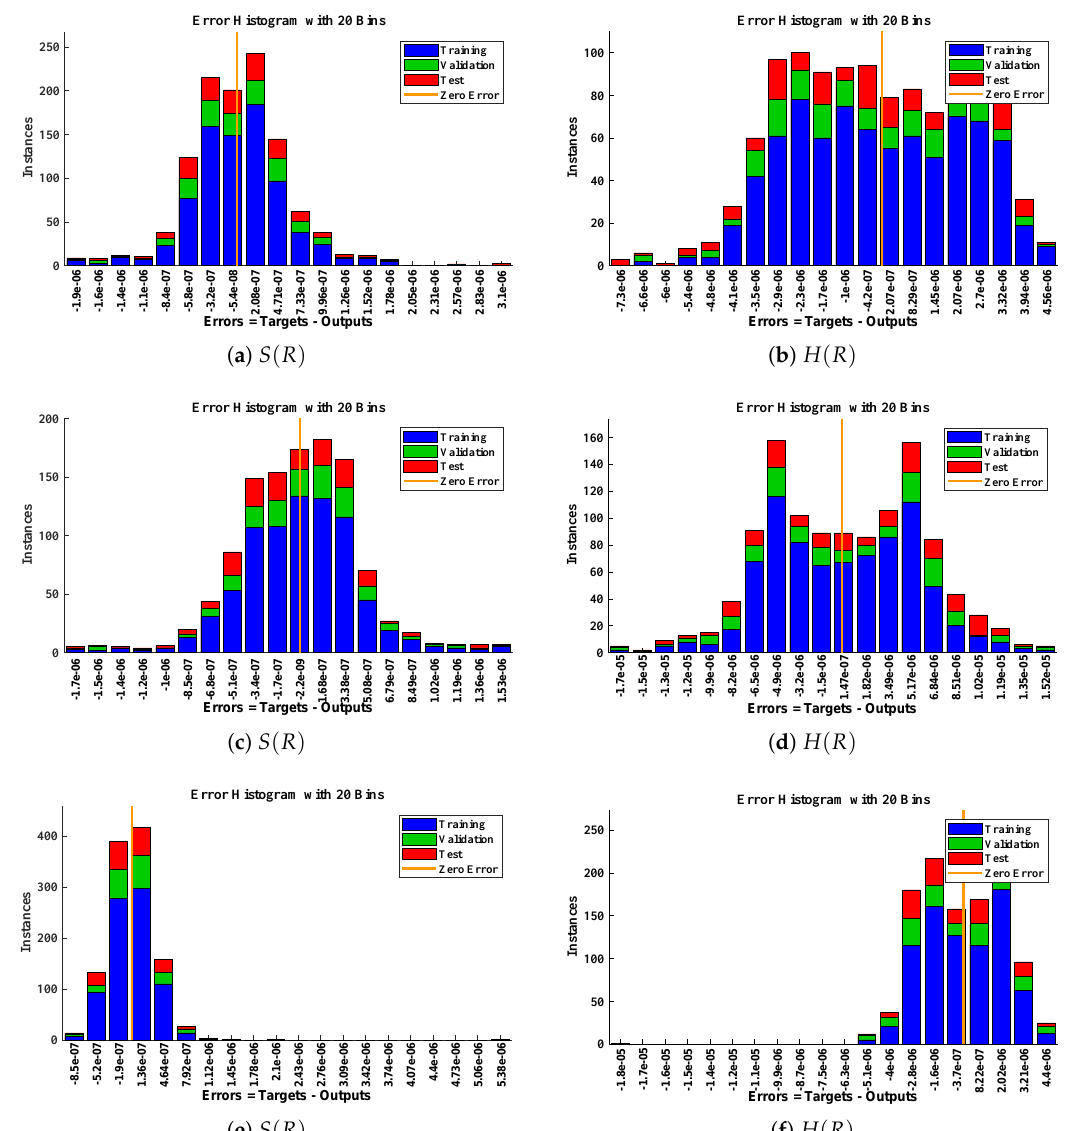
Figure 9. Error histogram analysis between targeted data and approximate solutions for scenario